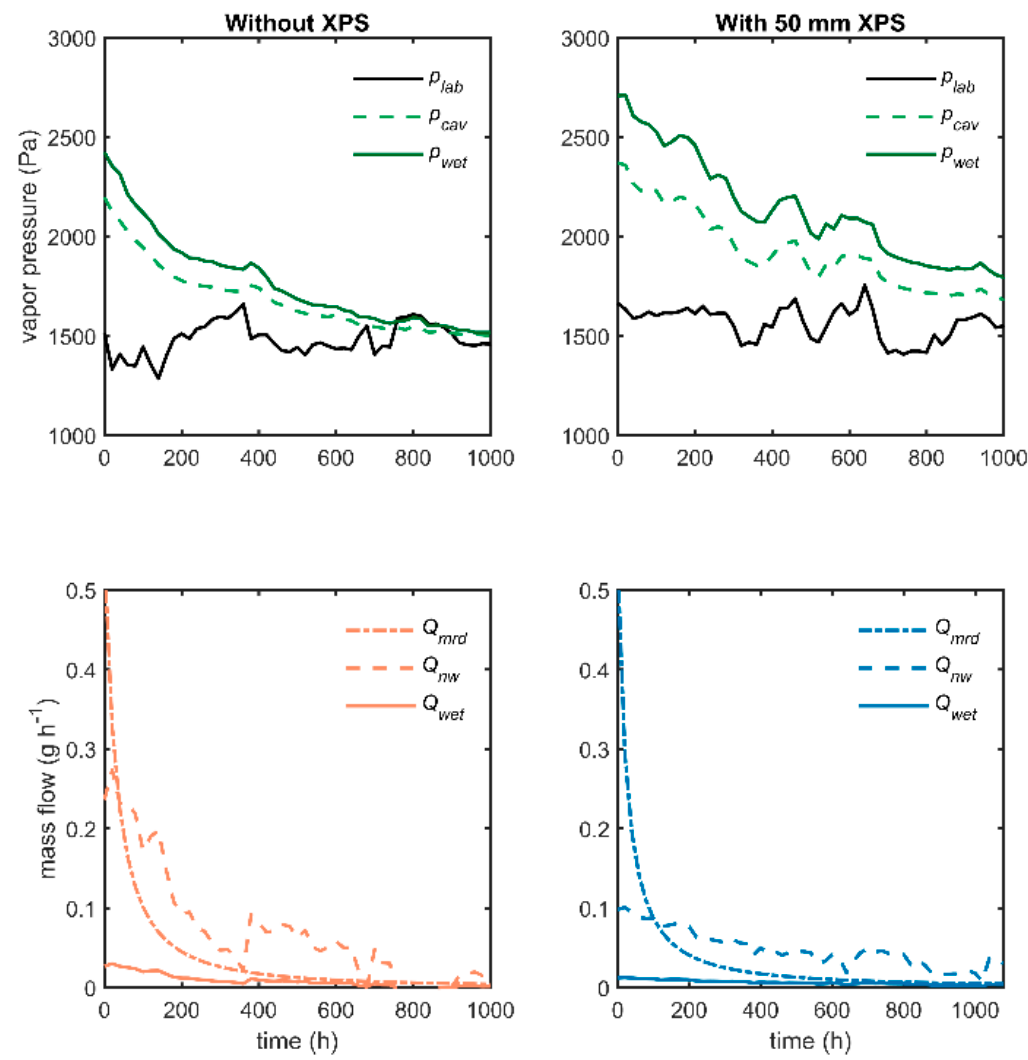
Figure 12. Vapor pressures and flows for walls with painted framing lumber (paint, w/o XPS and paint, w/ XPS).